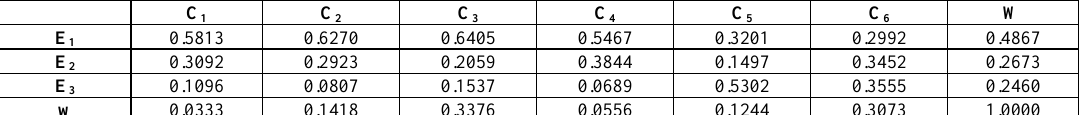
Table 11. The set of weights for the evaluation